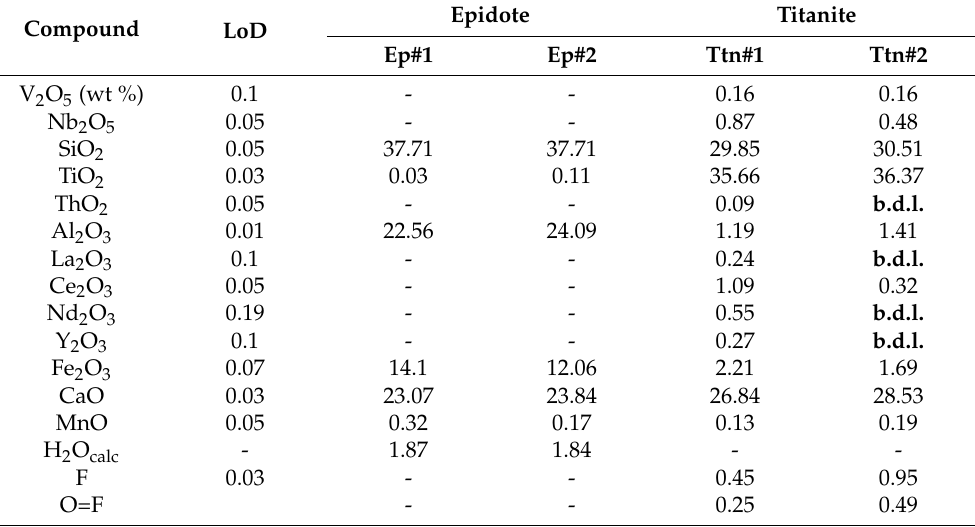
Table 3. Representative electron microprobe analyses (EMPA) of epidote and titanite crystal and their chemical formulae calculated on the basis of 25 O 2 − and 5 O 2 − ,